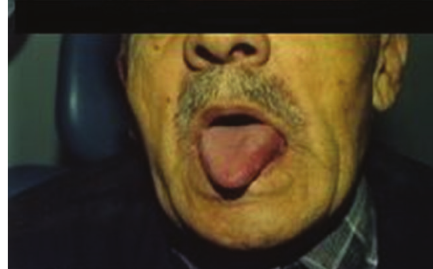
Figure 2: View of the tongue after total surgical